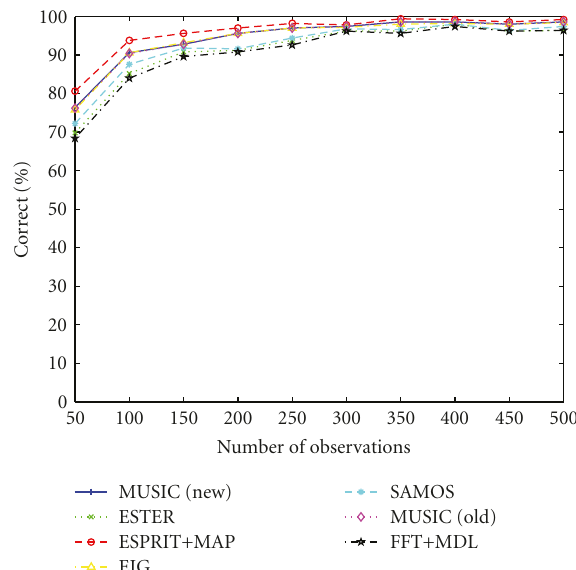
Figure 2: Percentage of correctly estimated model orders as a function of the number of observations for an SNR of 20dB.